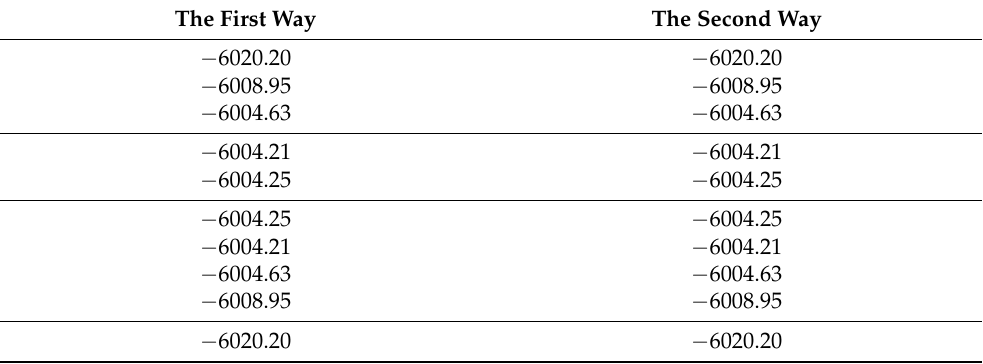
Table 4. Calculation of the potential on the line L in the case of a plane-parallel version of this system, when c = ∞ and c M = ∞ . N was taken to be